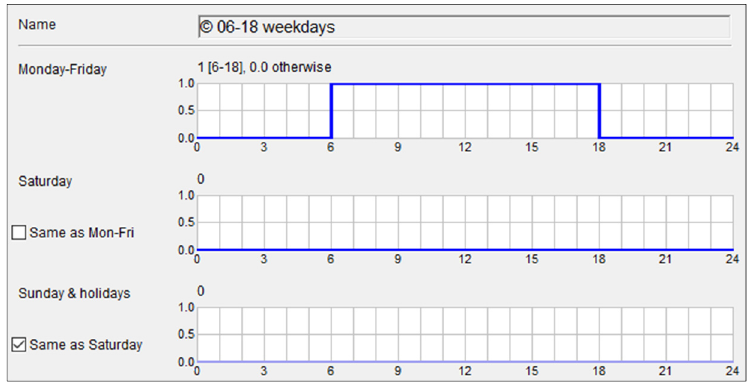
Figure 3. Schedule for occupants, lighting, and equipment.